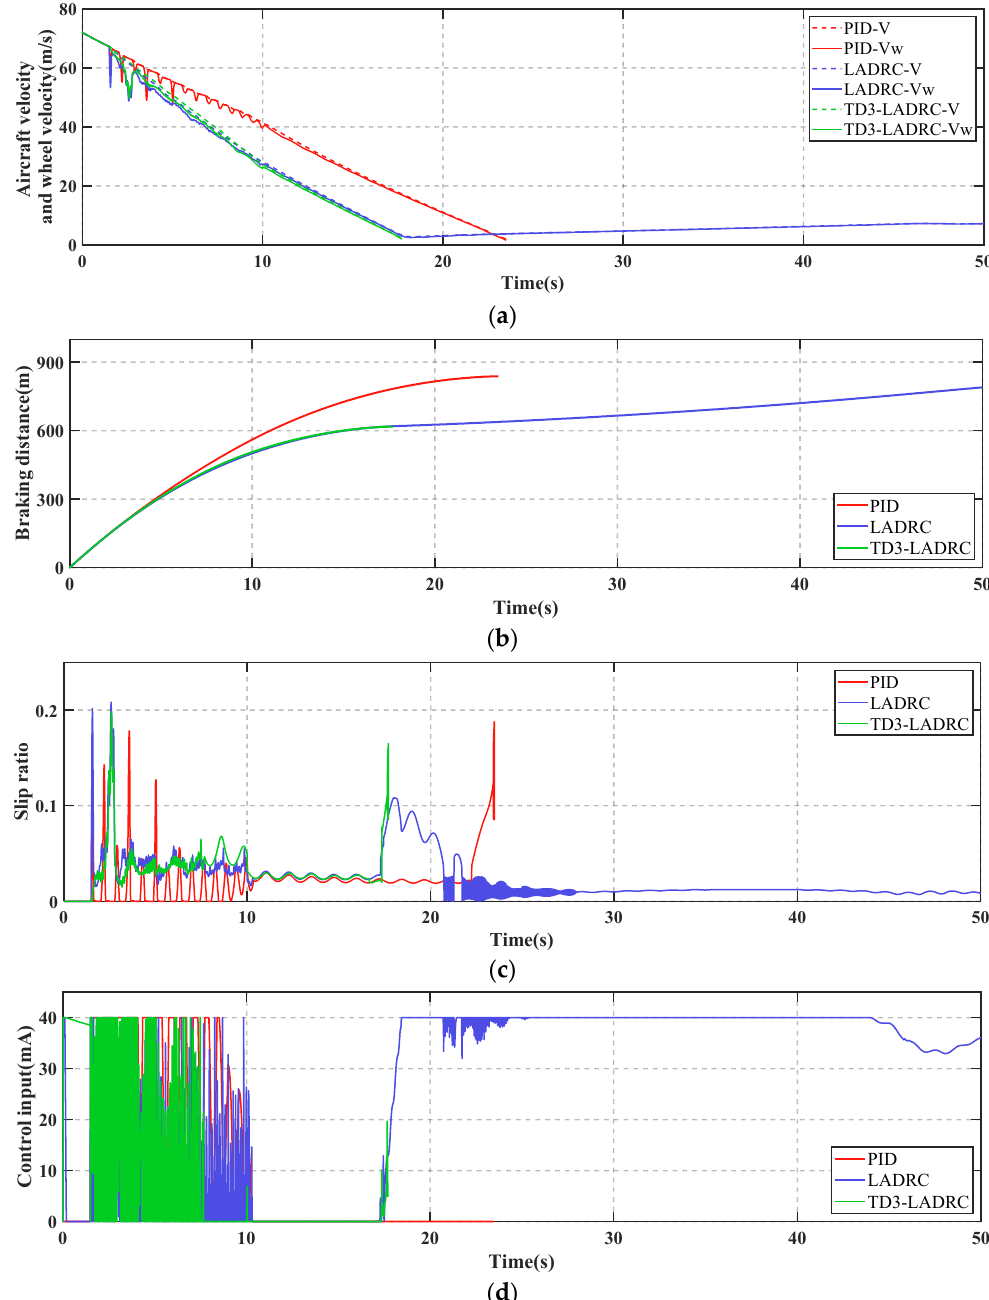
Figure 9. ( a ) Aircraft velocity and wheel velocity; ( b ) breaking distance; ( c ) slip ratio; ( d ) control input.